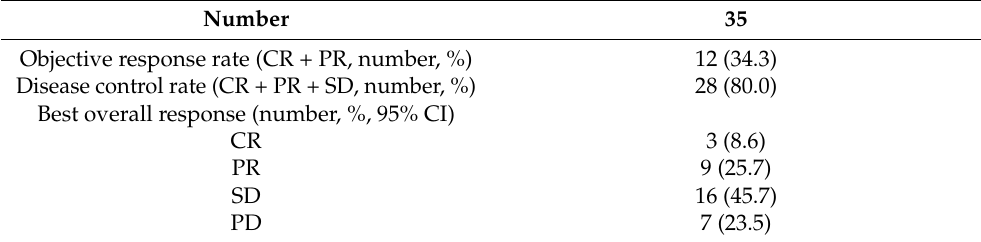
Table 3. Multivariate analysis of clinical parameters for the prediction of progression-free survival. 95% Confidence N Hazard Ratio Interval Age ≤